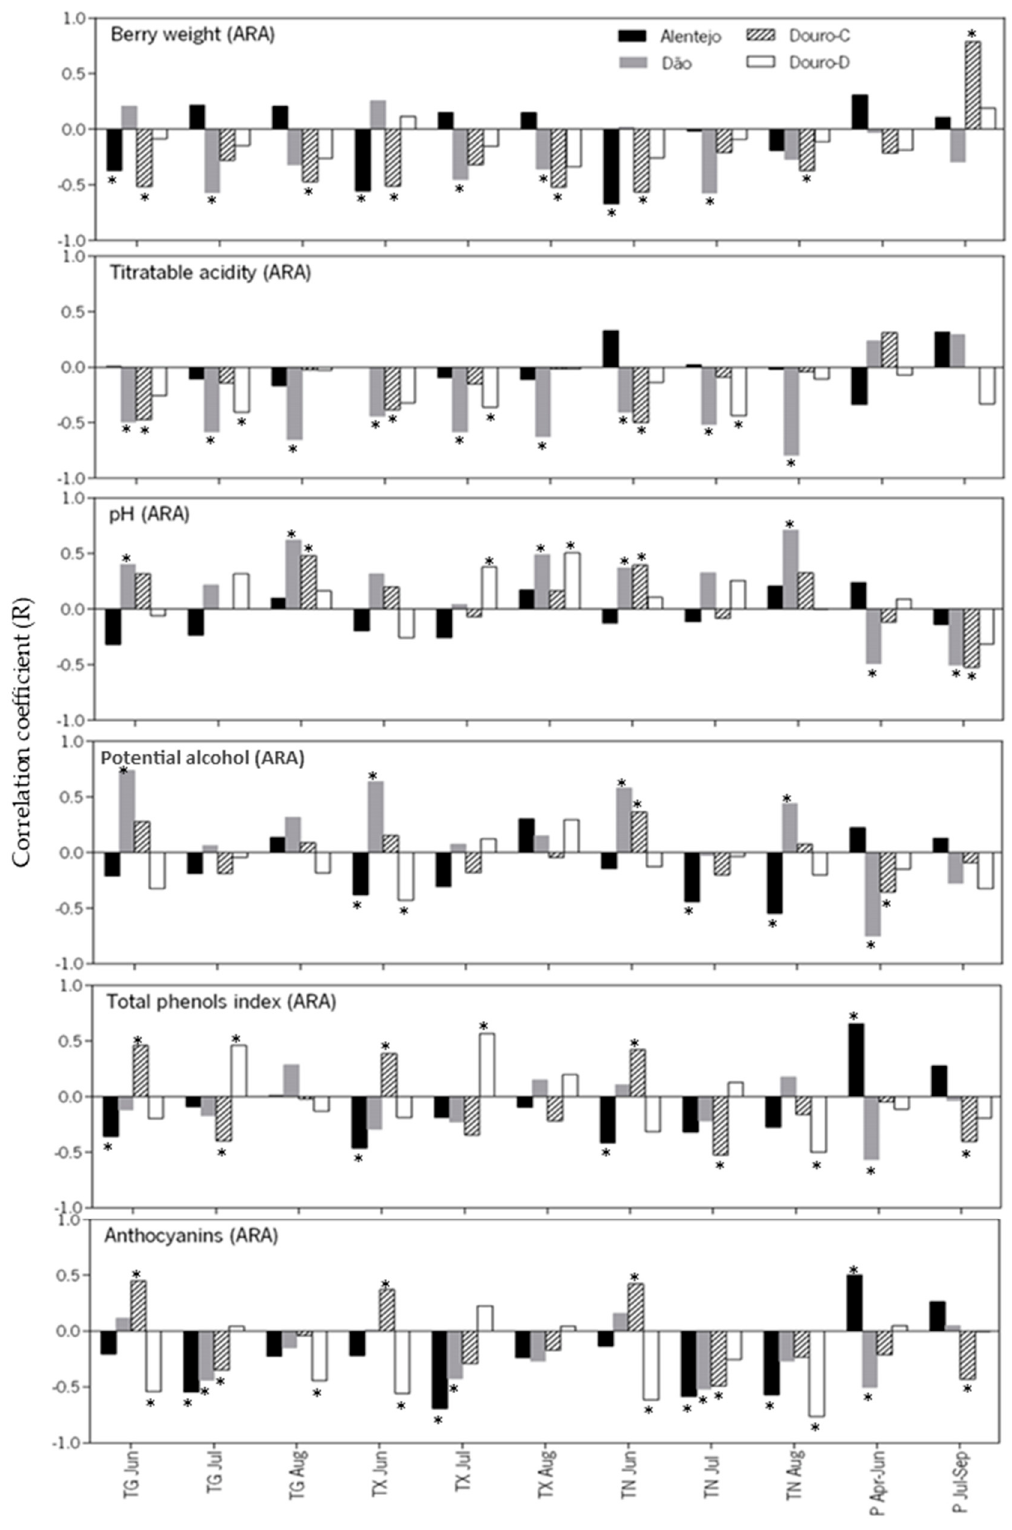
Figure 3. Pearson product-moment correlation coefficients between grape berry quality parameters (berry weight, titratable acidity, pH, potential alcohol, total phenols index and anthocyanins) at maturity and climate variables for cv. Aragonez (ARA). Months are described by their initial letters. TG—average temperature; TX—maximum temperature; TN—minimum temperature; P—precipitation. Statistically significant correlation coefficients at 1% significance level are highlighted with an *.